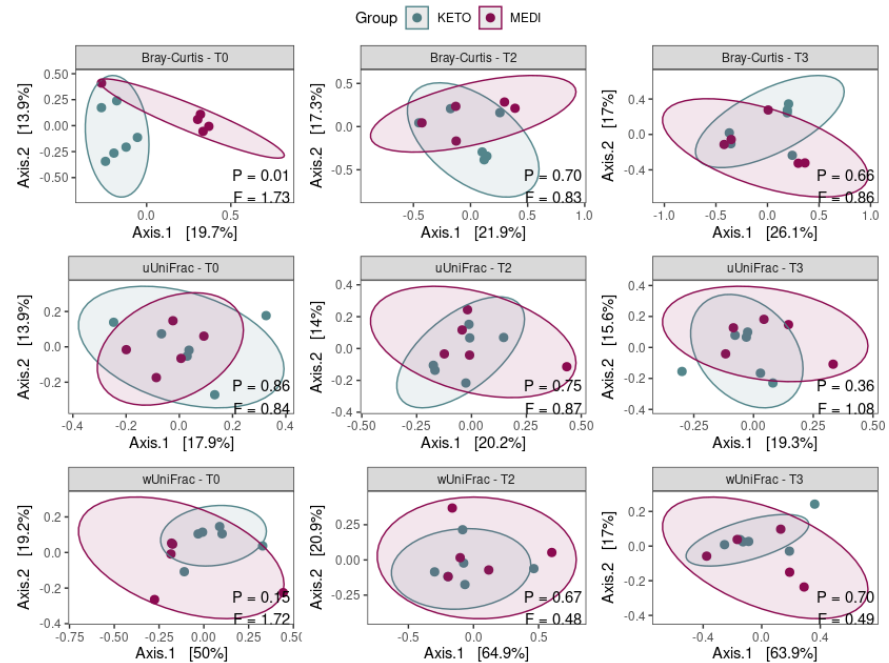
Figure 5. Principal coordinate analysis plots with comparisons of gut microbiota composition between diets at each time point. Each subplot concerns a combination of beta diversity metric (Bray-Curtis, unweighted UniFrac, or weighted UniFrac) and timepoint (T0, T2, or T3). Ellipsoids depict the 90% compositional confidence interval. Statistical significance was evaluated by the PERMANOVA test, with statistical summaries included in each subplot. KETO = 6 patients who followed a very-low-calorie ketogenic diet (VLCKD), MEDI = 5 patients who followed a low-calorie Mediterranean diet (MD). time point (see Figure 6 and Supplementary Tables S6 and S7 online).